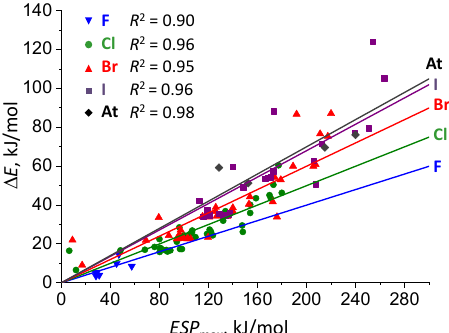
Figure 6. Correlation between calculated complexation energy ∆ E and the extremal value of electrostatic potential ESP max , measured in the region of σ -hole of X atom on the surface of equal electron density taken at 0.001 electron / Bohr 3 level for R–X ··· O = PMe 3 halogen-bonded complexes studied in this work (X = F, Cl, Br, I, At). The solid lines correspond to Equation (4).